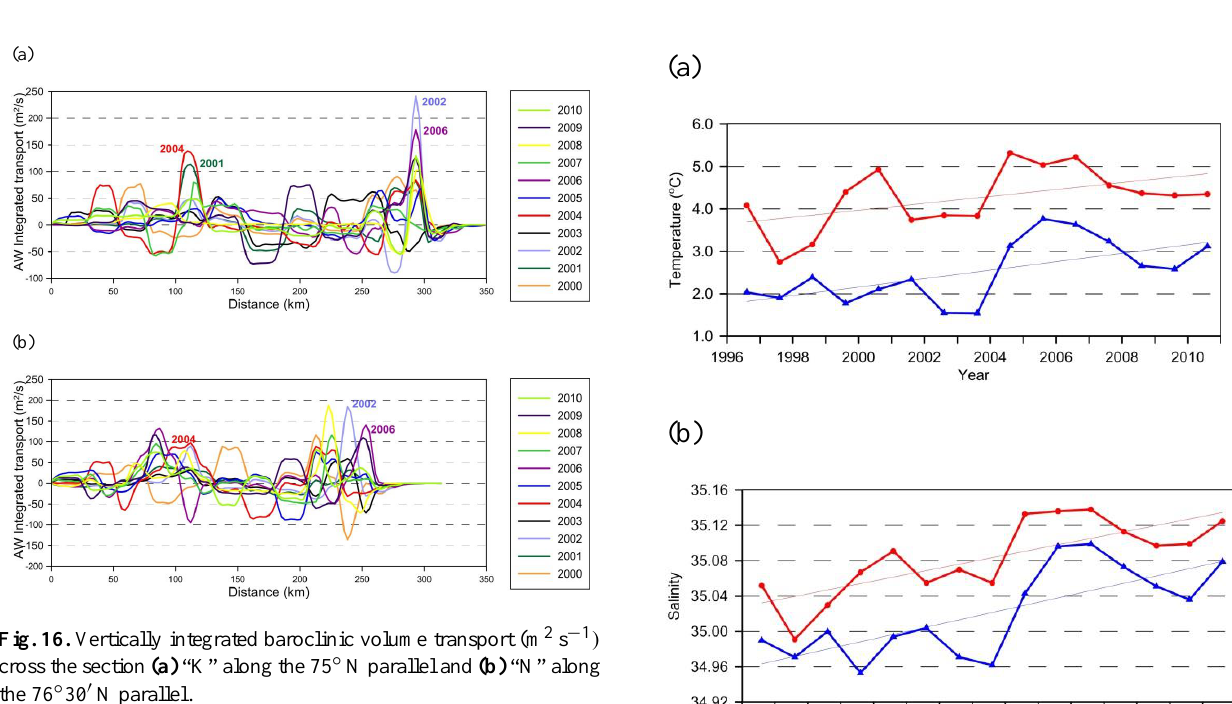
Figure 15.Temperature at 200 dbar in the cold 2002, and warm 2005, 2006. The western 2 Fig. 15. Temperature at 200dbar in the cold conditions 2002, and warm 2005, 2006. The western frontal line (isotherms 2–2.25 ◦ C) is marked by the grey line. frontal line – isotherms 2-2.25 °C - is marked by the grey line. 3